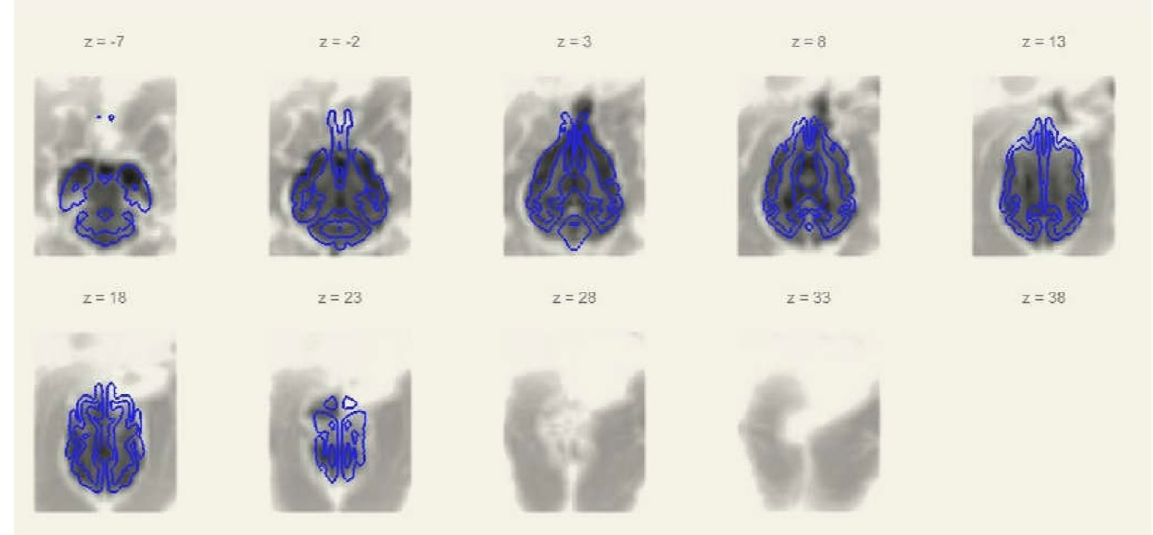
Figure 2. Sample of the coregistration of the grey matter mask to the mean functional image. The standard grey matter mask from the Nitzsche atlas 15 was applied to the normalized